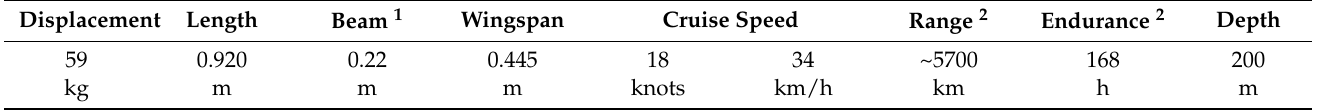
Figure 2. Two views of the drone ( a ) port side view; ( b ) starboard prospective view. Table 1. AUV Albacore : characteristics and performances (estimated).